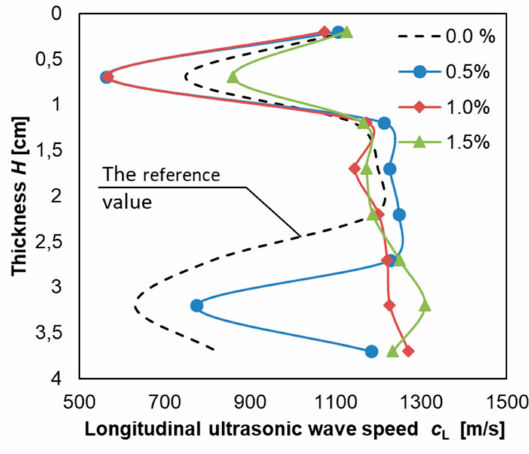
Figure 8. The results of the course of the longitudinal velocity of the ultrasonic wave c L along the thickness H of the cement mortar used to make the